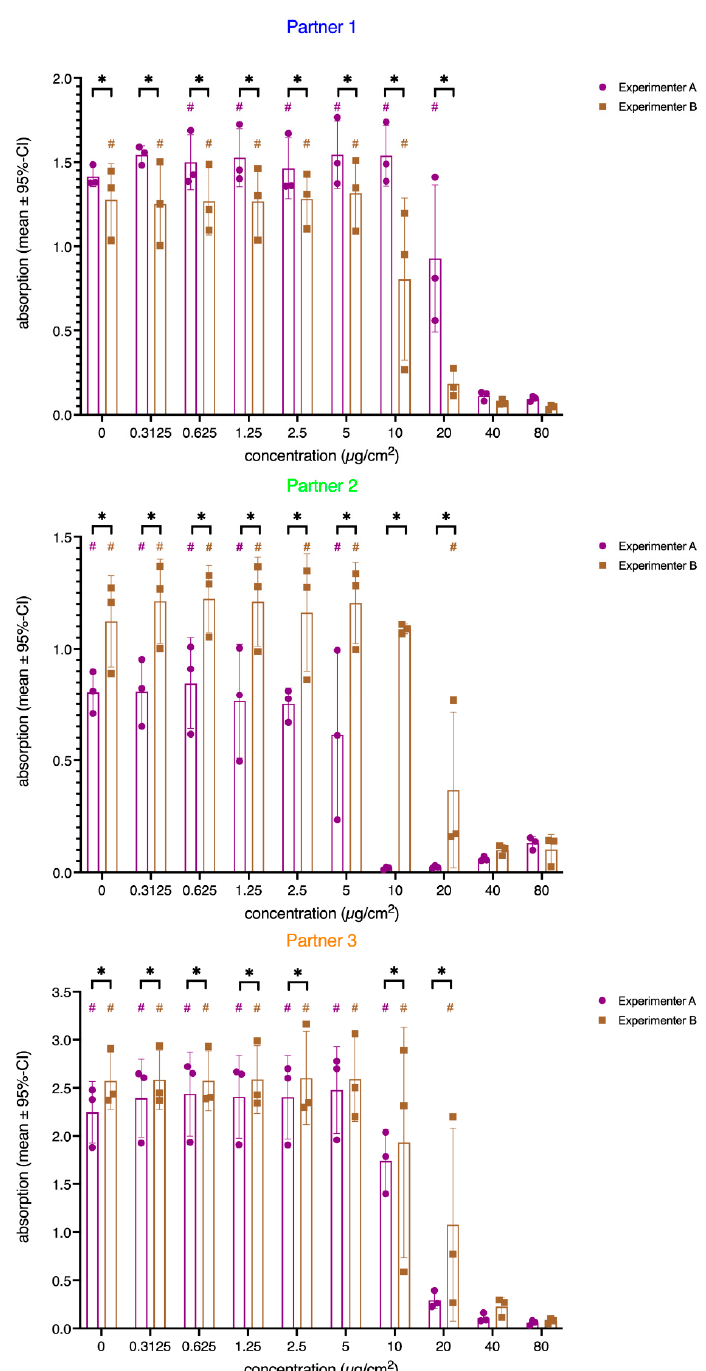
Figure 5. Bar chart showing the interaction of the factors concentration (x-axis), partner (panels Partner 1–3), experimenter within the partners (color-coded bars), and biological replicate (purple and brown dots and squares). Bars represent mean values (corrected absorption), and error bars indicate the corresponding standard deviation. Individual measures of the three biological replicates are given as color-coded dots and squares. # above the bars indicate significant differences among the biological replicates of the two experimenters at a certain concentration step ( p < 0.05 according to pairwise comparisons, adjusted for multiple tests). Adjusted significant comparisons between the two experimenters within in the partners are given above the bars (*: p < 0.05 according to pairwise comparisons, adjusted for multiple tests). The concentration is the administered concentration of the ENMs based on the initial